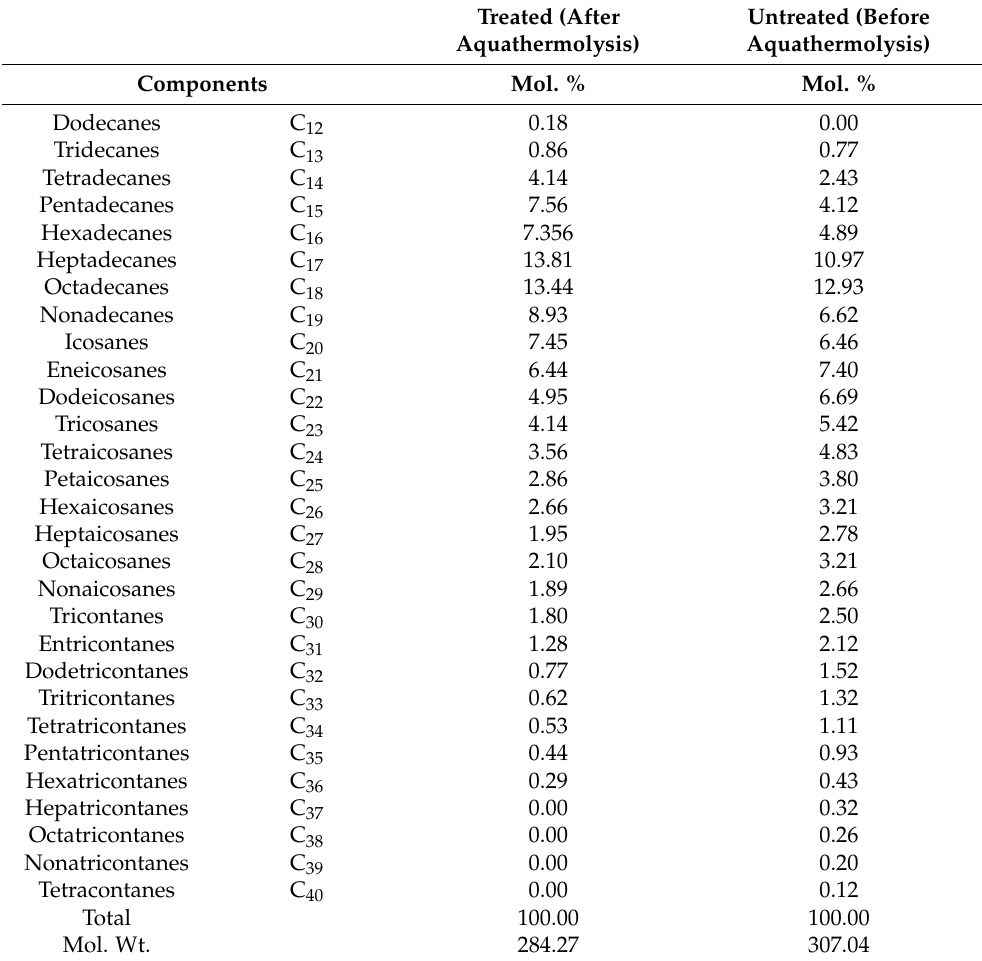
Table 6. Mole percentage of the crude oil before and after catalytic aquathermolysis using IL-10.